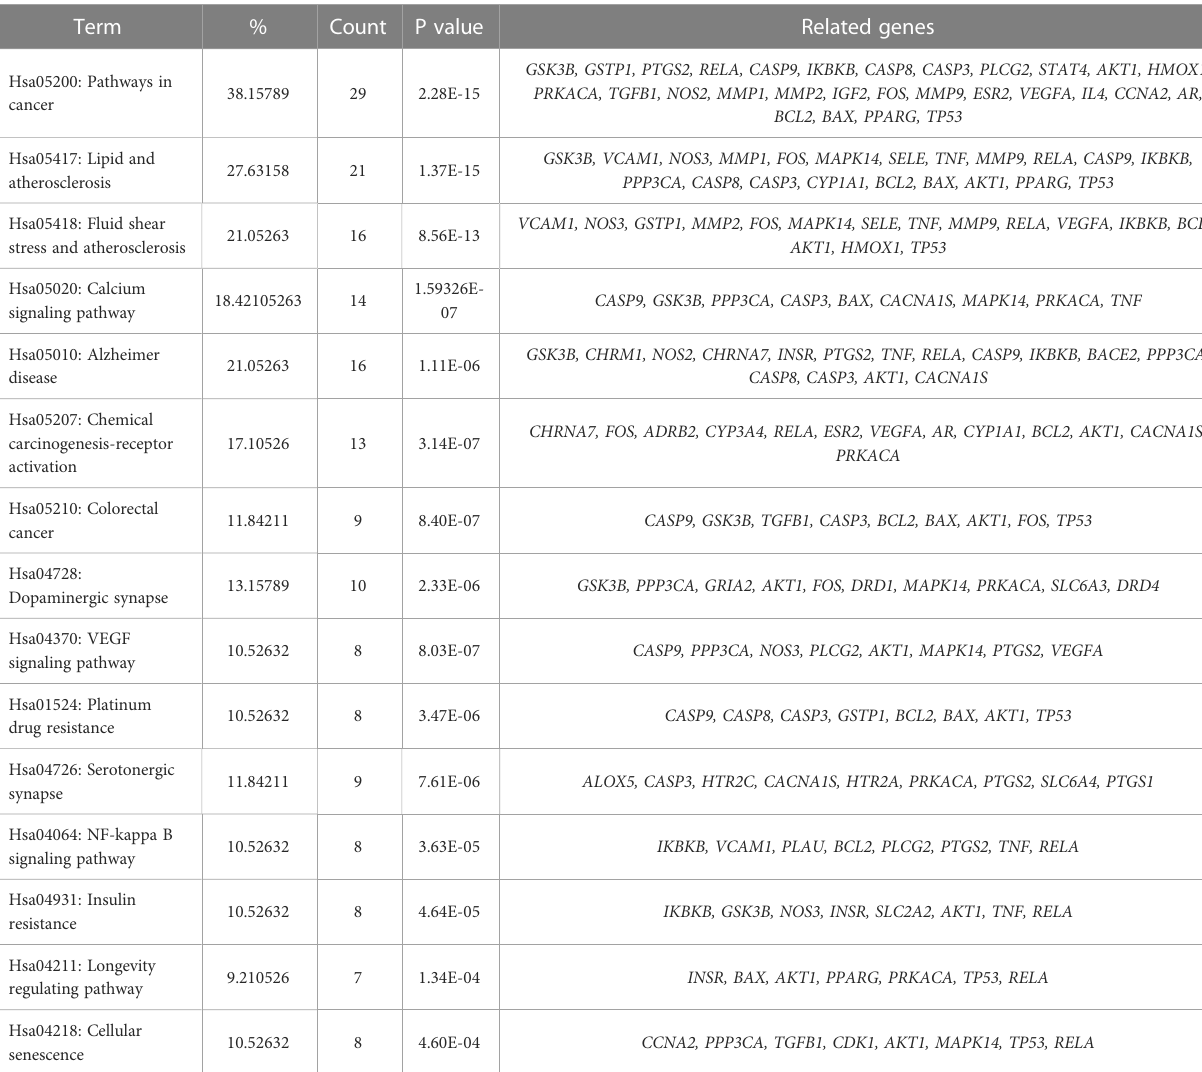
TABLE 3 KEGG pathway enrichment